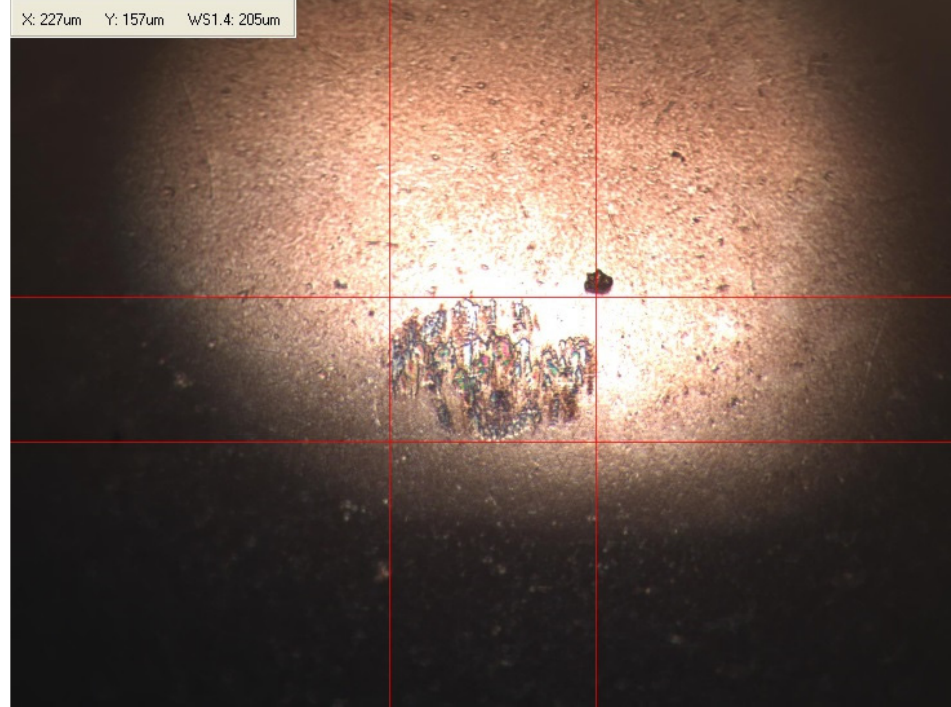
Figure A4. SAE 30—95% m/m; DO—5% m/m.